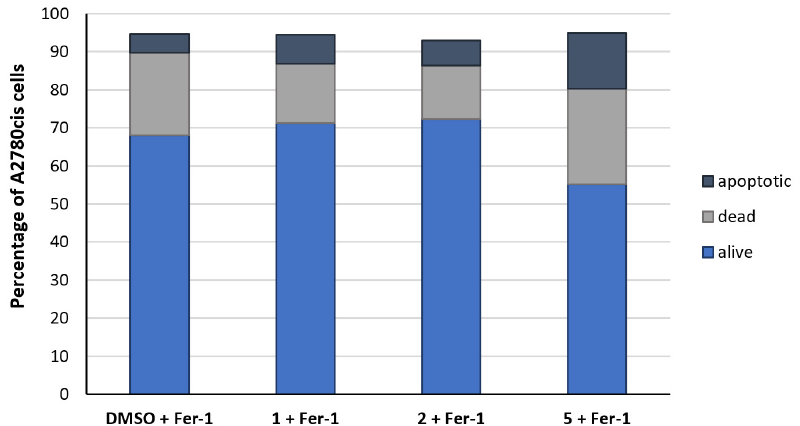
Figure 5. Differentiation of the A2780cis cell population (%) into apoptotic (dark blue), dead (grey), and alive cells (blue) after incubation for 24 h with Fer-1 (1 μ M) in the absence of the compounds (neg. control, DMSO) and with 1 , 2 , or 5 (1 μ M). Data are expressed as mean of two experiments.